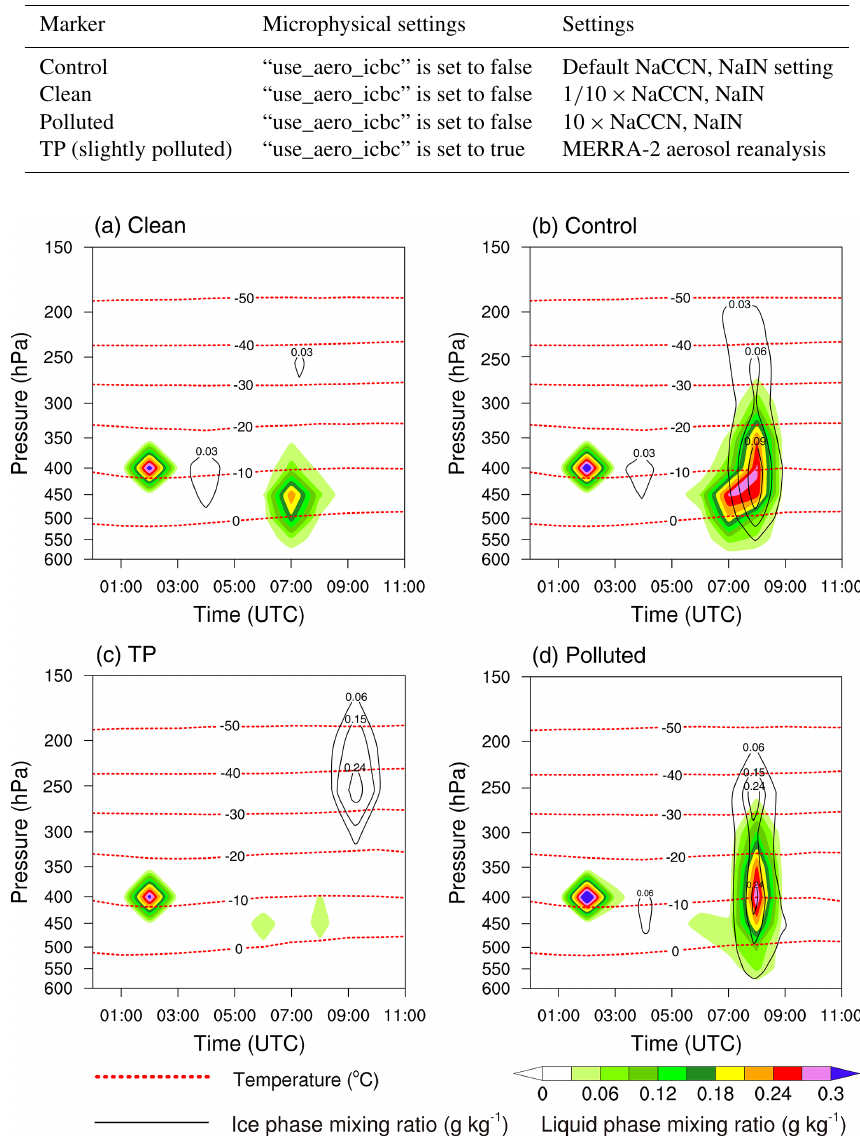
Table 4. Experimental settings.